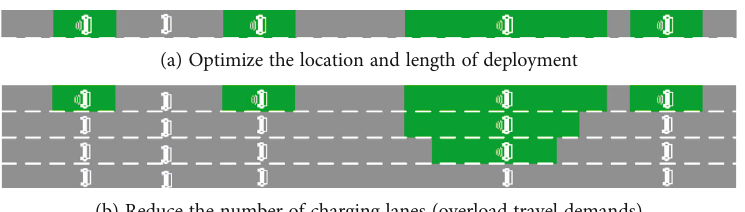
Figure 2: Stretch of optimized DWC lanes in this paper (the marked green lanes are the designed DWC lane that allows EVs to run and charge